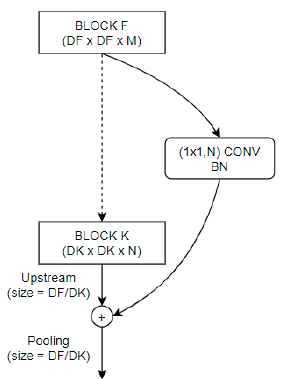
Figure 2. Connection between 2 blocks with upstream and pooling layers (called Add block). BN denotes Batch Normalization and the normal line represents long skip connection between blocks while dash line states that there could be additional block(s) between block F and K.